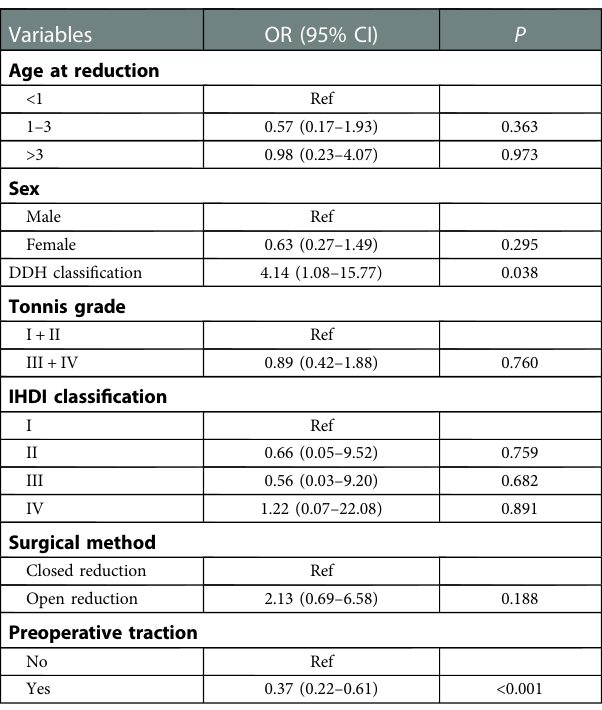
TABLE 3 In fl uencing factors of postoperative